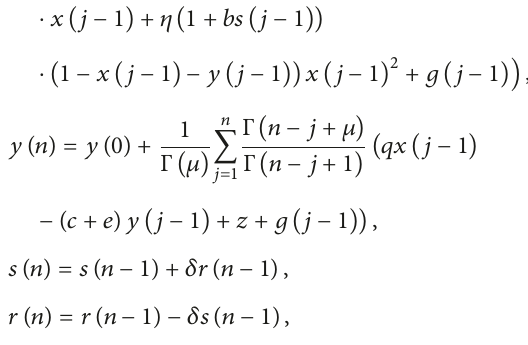
⋅ 𝑥 (𝑗 − 1) + 𝜂 (1 + 𝑏𝑠 (𝑗 − 1))